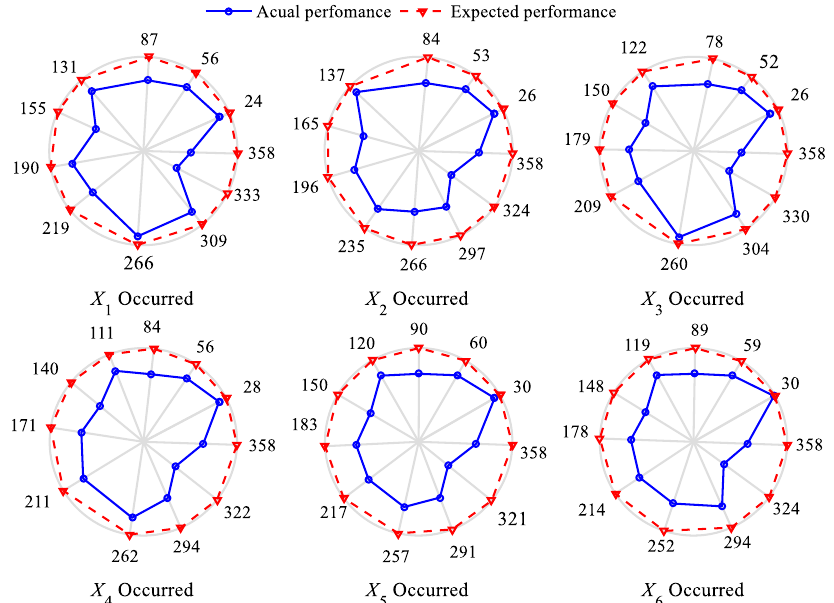
Table 5. Single FGHP performance evaluation value with node updating (from